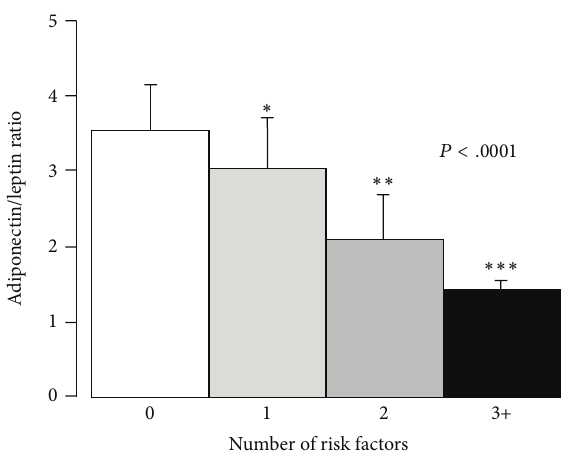
Figure 5: Plot of ratios of adiponectin/leptin versus number of risk factors. Subjects with ≥ 1 risk factors have a lower ratio than those without any risk factor. In addition, men with 2 risk factors have a significantly lower ratio than those with 1 risk, and those with ≥ 3 risks have significantly lower ratio than those with 1 or 2